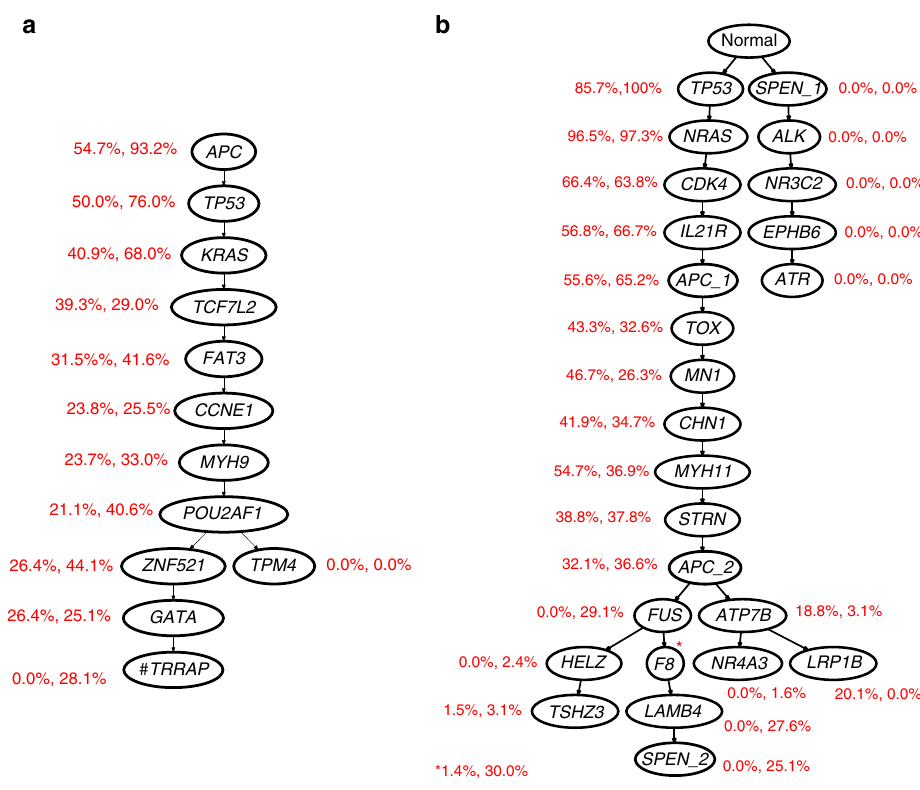
Fig. 8 B-SCITE mutation histories for two cases of colorectal cancer with liver metastases 39 . a CRC1 (CO5) and ( b ) CRC2 (CO8). Mutations are annotated with the VAFs of the two bulk samples (left: primary tumour, right: liver metastasis). Bulk data come from whole-exome sequencing (at 75.5×depth and 97.33% coverage) of pooled fl ow-sorted single cells (for aneuploidy detection). Single-cell data come from targeted panel sequencing (T1000 cancer gene panel) at mean depth 137× with an average coverage of 0.92. B-SCITE was run on mutations detected in the panel sequencing that had a minimum read depth of 20 in the bulk samples. Cells without any of the remaining mutations were discarded for being non-informative in the tree inference. These fi ltering steps left 12 mutations and 72 single cells for CRC1 (CO5), and 25 mutations and 86 single cells for CRC2 (CO8). Fluctuating VAFs are likely due to a combination of CNAs and artefacts from limited sequencing depth in the whole-exome sequencing data. Note that in CRC2, APC and SPEN have each two independent point mutations denoted as ( APC_1 , APC_2 , SPEN_1 and SPEN_2